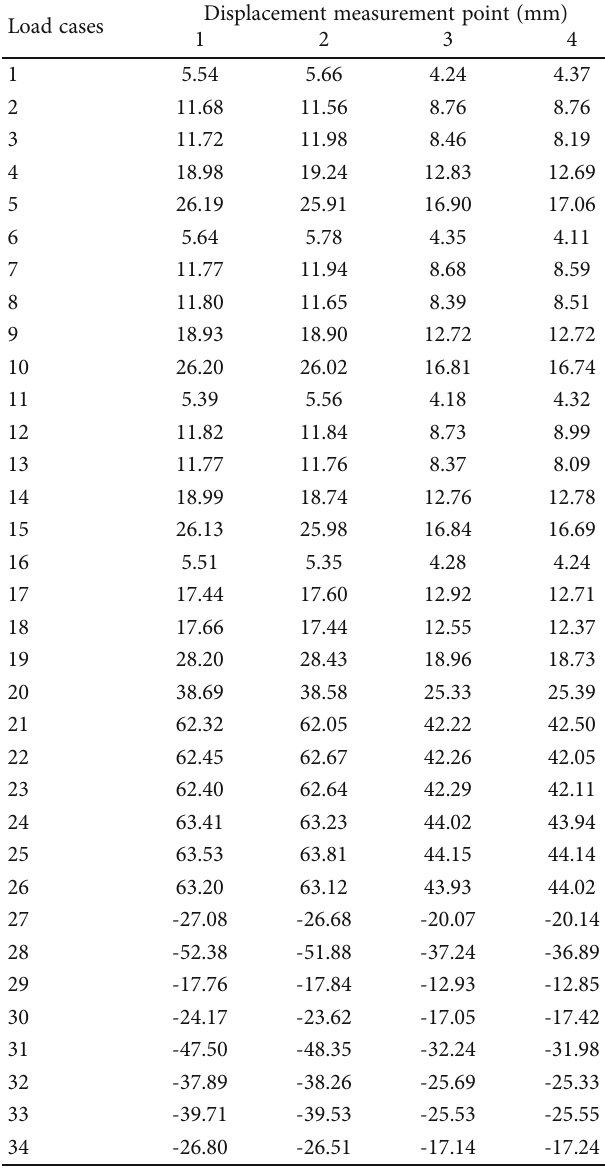
Table 3: Test results of four displacement points (unit: